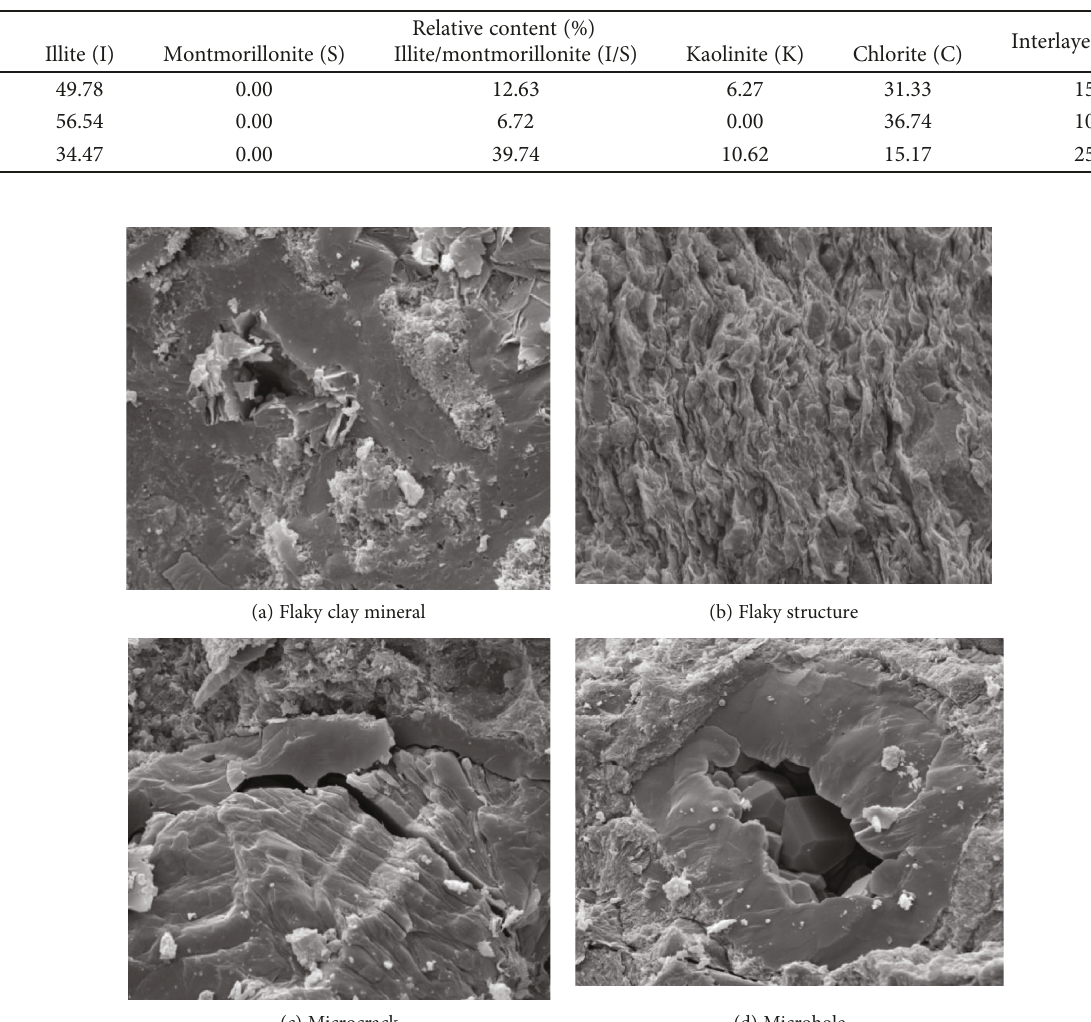
Table 2: Relative content of clay minerals.